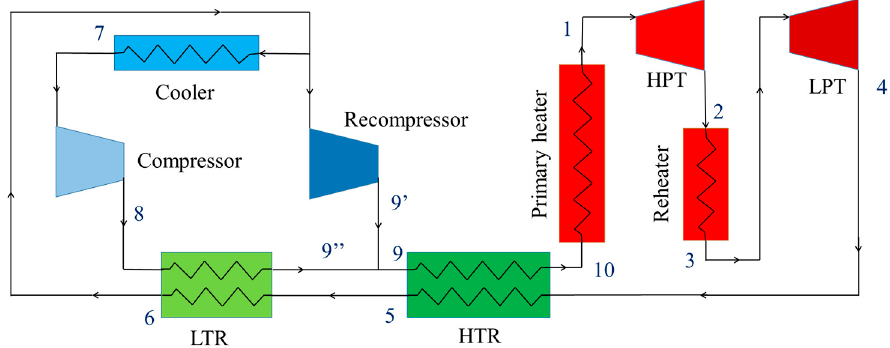
Figure 1. Schematic of recompression cycle with reheater.